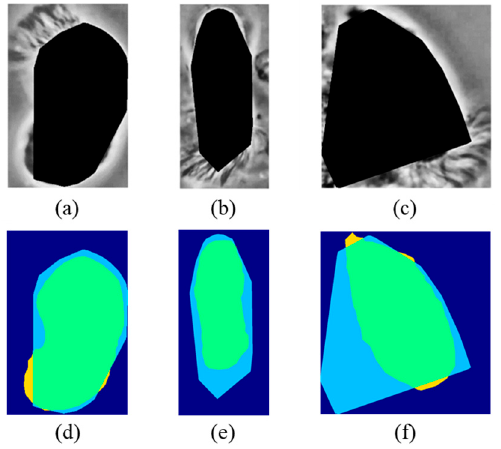
Figure 7. Examples of masked ciliated cells sampled from the dataset under different operative conditions: ( a ) cilia 2; ( b ) cilia 3; ( c ) cilia 4. The intersections over unions (IoUs) are shown ( d – f ), scored measuring 0.84, 0.67, and 0.60, respectively.